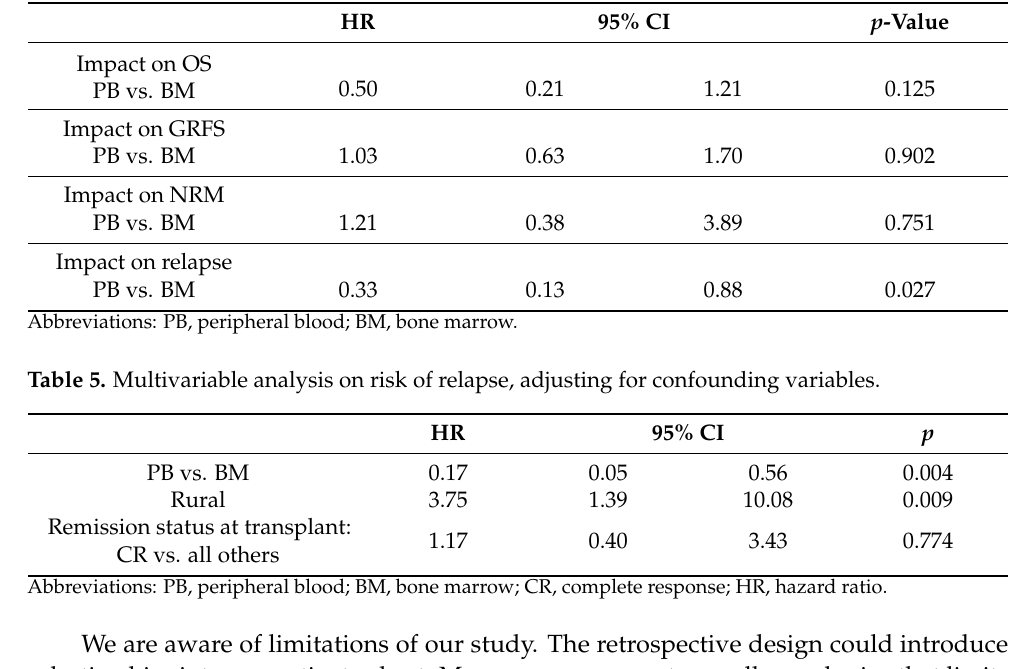
Table 4. Univariable analysis of effect of PB versus BM graft on transplant outcomes. HR 95% CI p -Value PB vs. BM